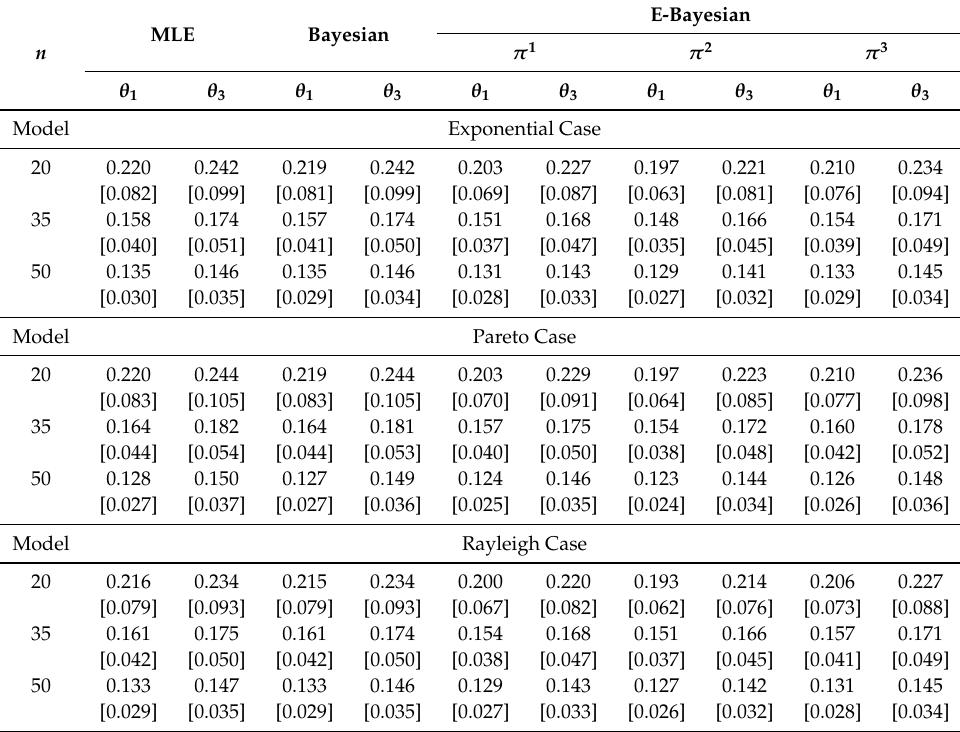
Table 1. The AB and MSEs (within bracket) of point estimates with ( c 1 , c 2 , c 3 ) = ( 1.5,2,1.2 ) .